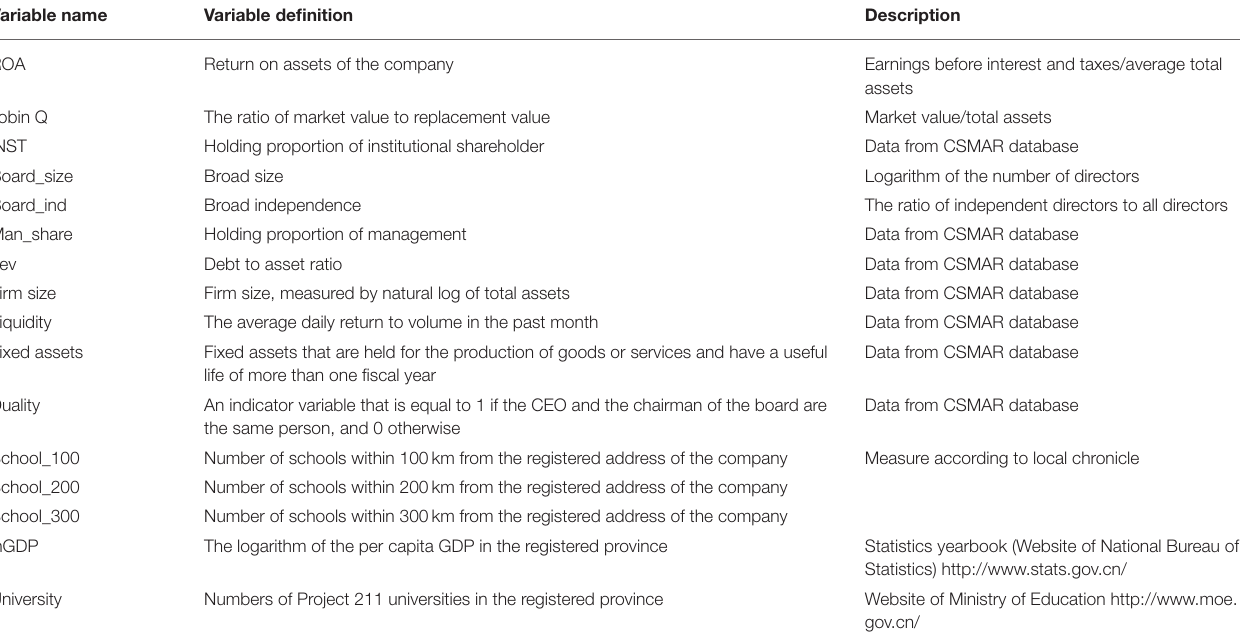
TABLE 1 | Definitions and calculations of the